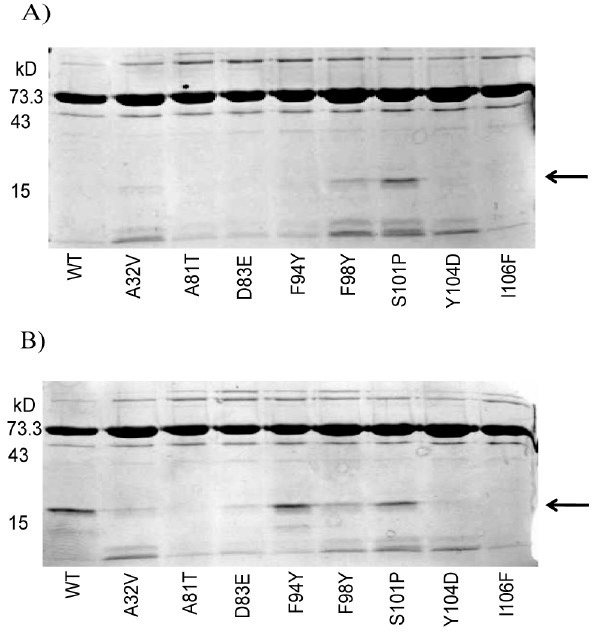
Figure 3. Limited proteolytic digestion of EsaR* variants by thermolysin. A) Patterns of thermolysin cleavage of EsaR* variants in the absence of AHL. B) Patterns of thermolysin cleavage of EsaR* variants in presence of AHL. Arrows indicate bands of interest corresponding to the N-terminal domain of EsaR. The images are representative of experiments performed in